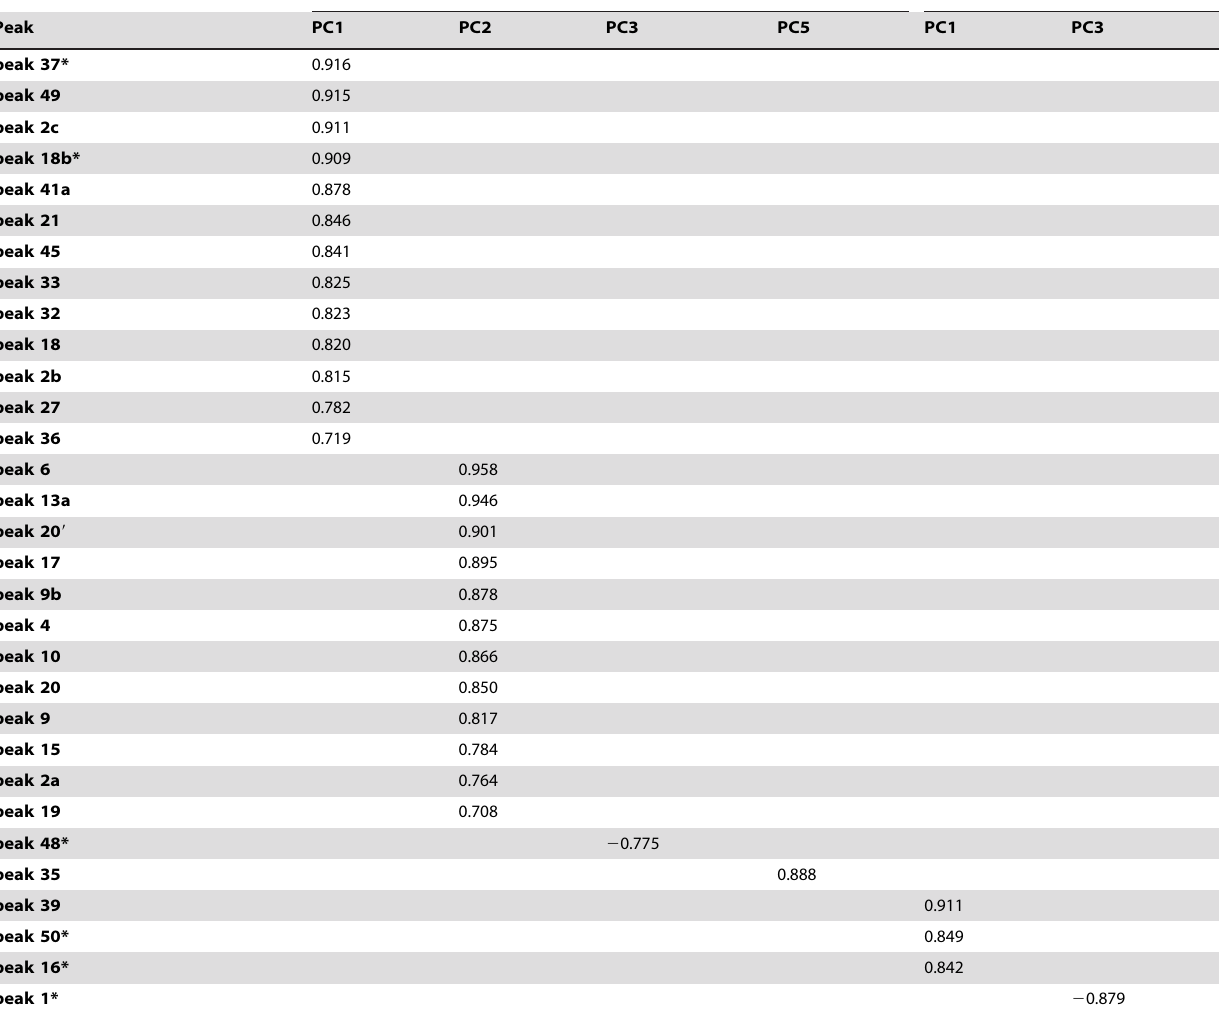
Table 2. The factor